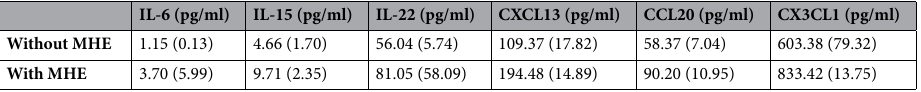
Table 2. Serum cytokines with significant differences between patients with and without MHE. Values are median (IQR, Interquartile Range). Differences between patients were tested using non-parametric Wilcoxon test and adjusted by FDR (see “Methods”).